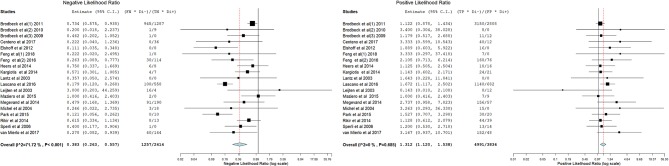
Forest plot showing negative and positive likelihood ratios of the II-ESI studies (individual studies: size of the squares are proportional to weights used in meta-analysis; the summary measure: center line of the diamond; associated 95% confidence intervals: lateral tips of the squares and the diamond).